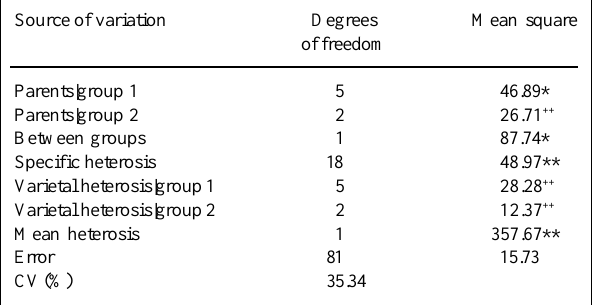
hybrids, for grain yield, in 1